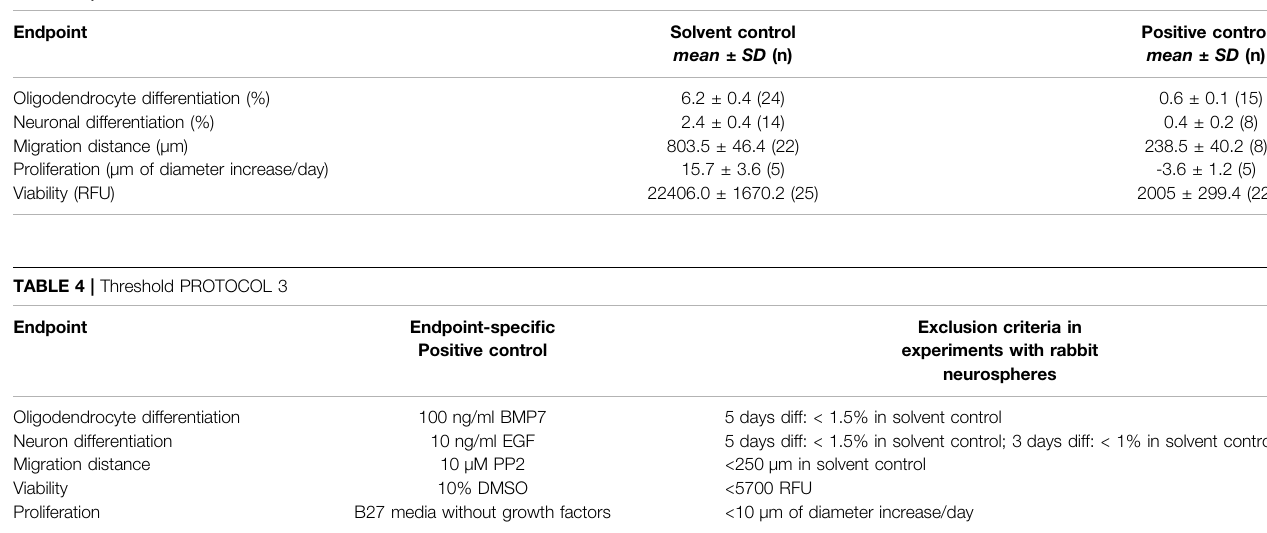
TABLE 3 | Results of PROTOCOL 3